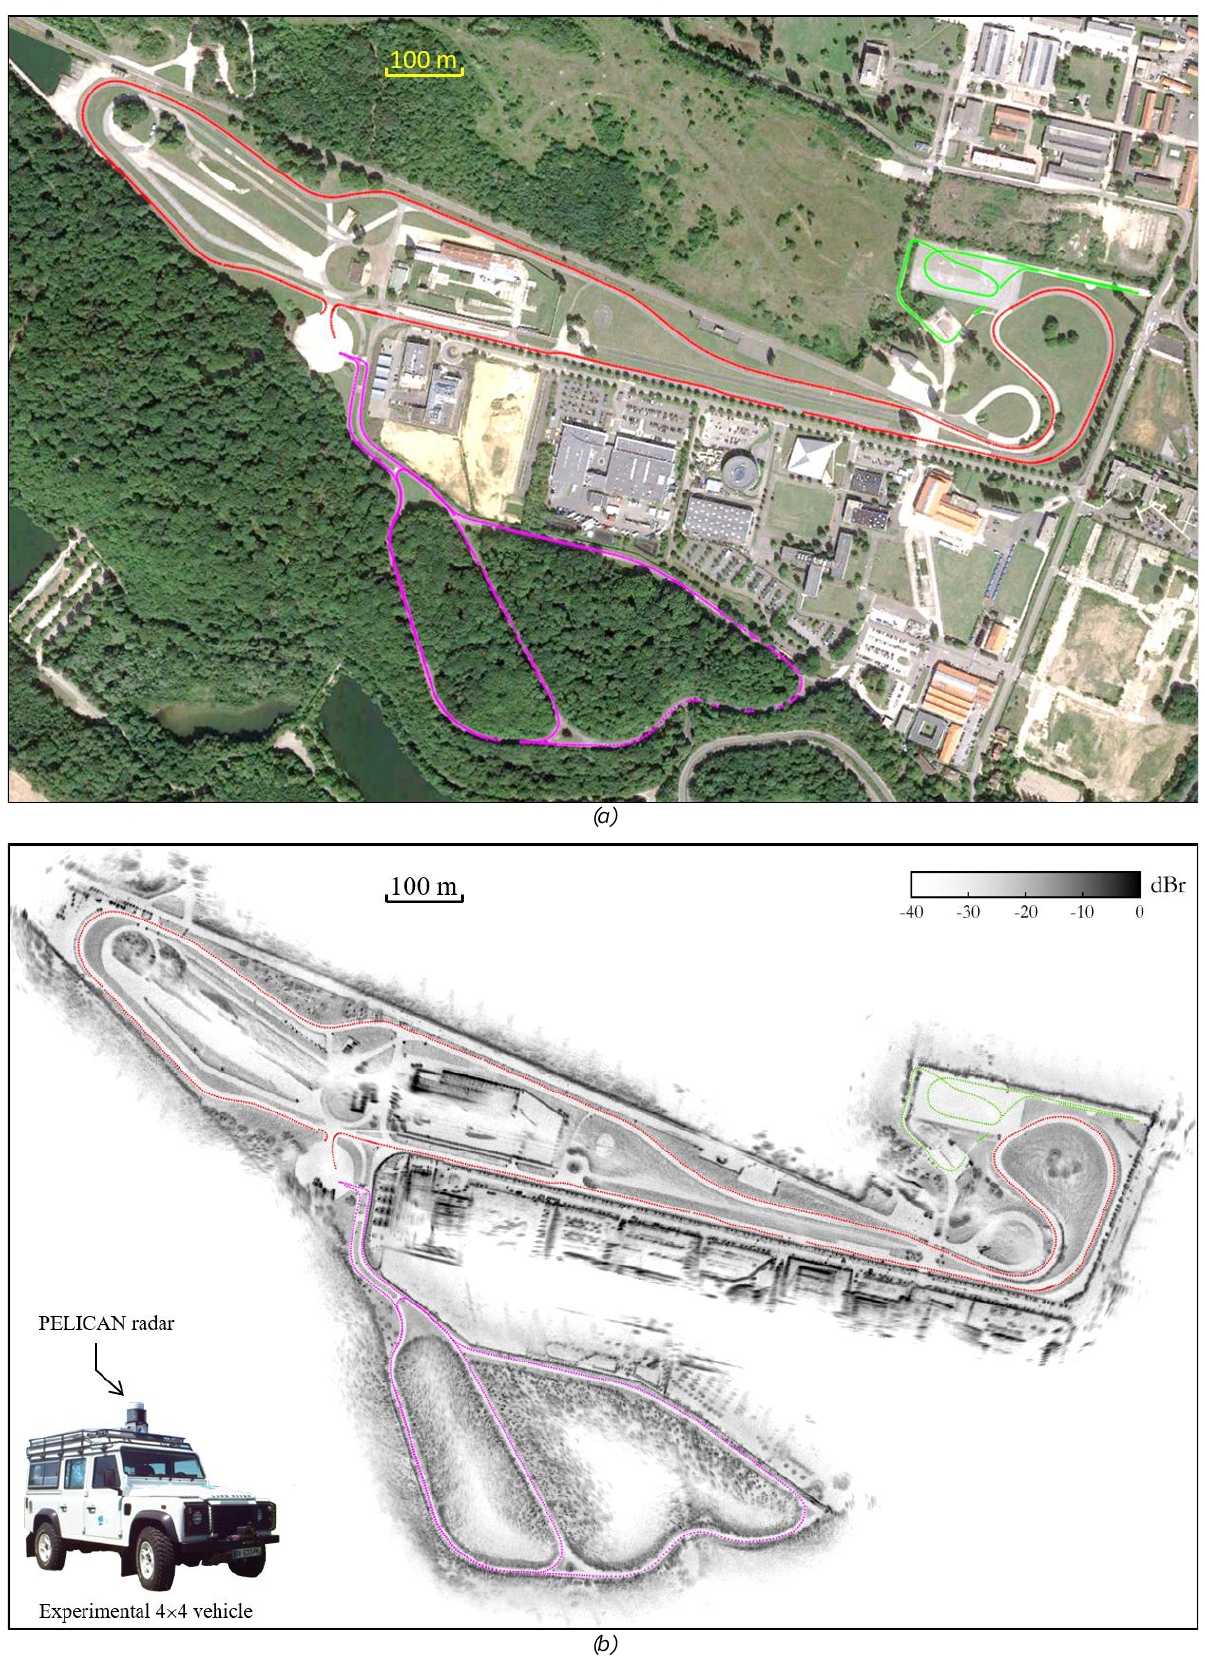
Figure 6. Example of radar map construction. (a) Aerial image of the test zone. Green, red and magenta dots indicate three trajectories (GPS data) followed by the vehicle, and which are used to build the radar map. (b) 2D radar map. The grey level variations indicate the amplitude’s variations of the measured radar signal. Colored dots: computed vehicle’s